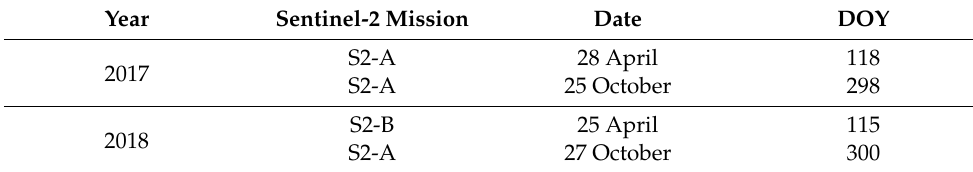
Table 4. Soil salinity appraisal calendar at the Quinta do Canal and Pranto rice fields: date and calendar day (day of the year: DOY) corresponding to the acquisition of Sentinel-2 (S2) satellite data for 2017 and 2018, before and after the rice cultivation period, for the condition of bare